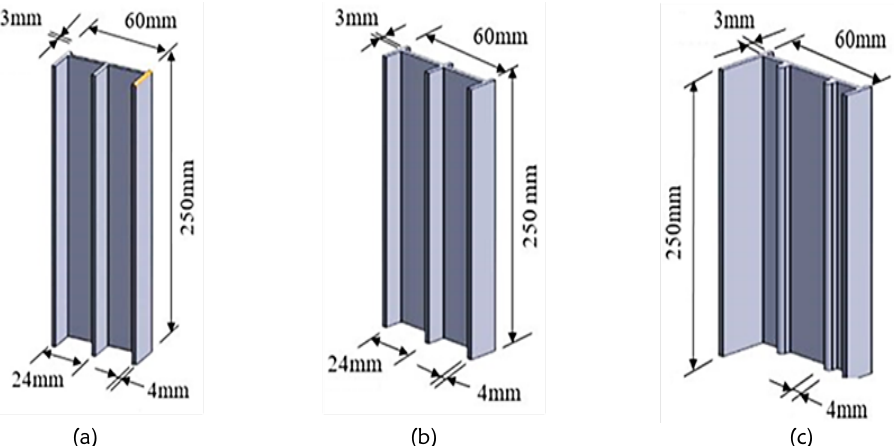
Figure 2: Window frame fabrication by stir casting process of hybrid composites (a) top part, (b) side part and (c) bottom